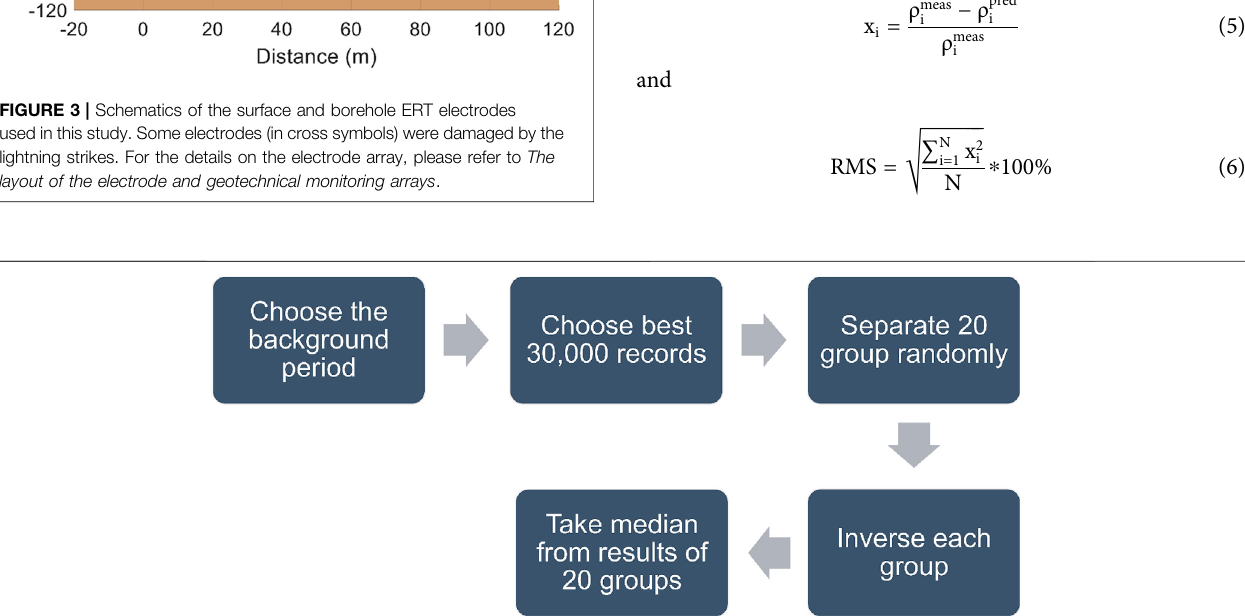
FIGURE 4 | Flow chart of the processing procedure of our massive ERT data. For the details on ERT data processing, please refer to Data acquisition and processing .